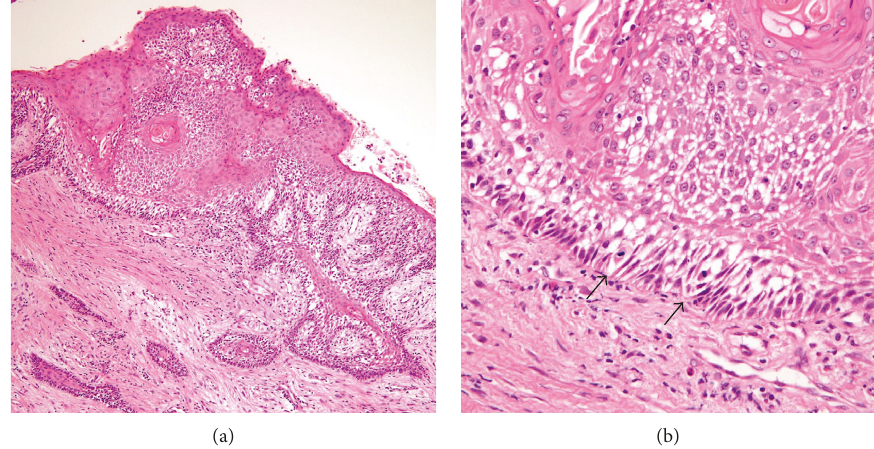
Figure 6: Unusual ameloblastomatous change of the OKC. (a) Only part of the lining epithelium shows papillary hyperplasia with ameloblastomatous epithelial elongation. (b) The suprabasal layer shows stellate reticulum-like formation, and the basal layer shows palisading tall columnar cell nuclei with focally mitoses (arrowheads) (HE; original magnification: × 40 (a) and × 200 (b)).